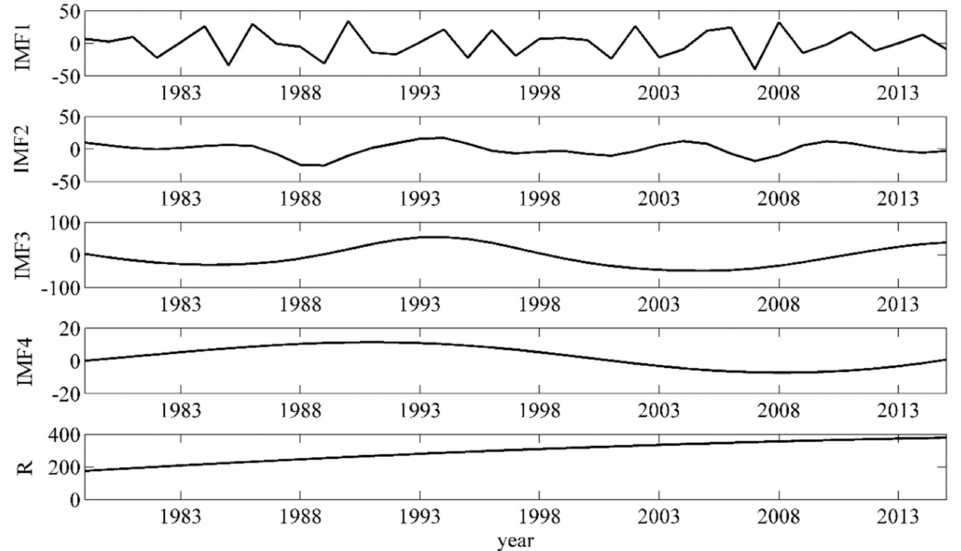
Figure 2. The temporal changes in original signal of maize yield during 1979–2015.